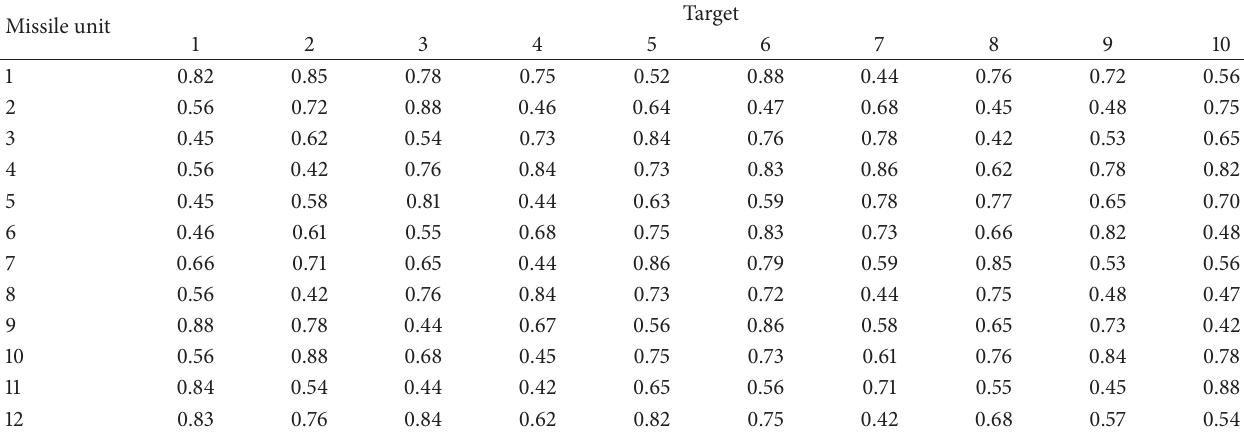
Table 5: The table of missiles damage probability.